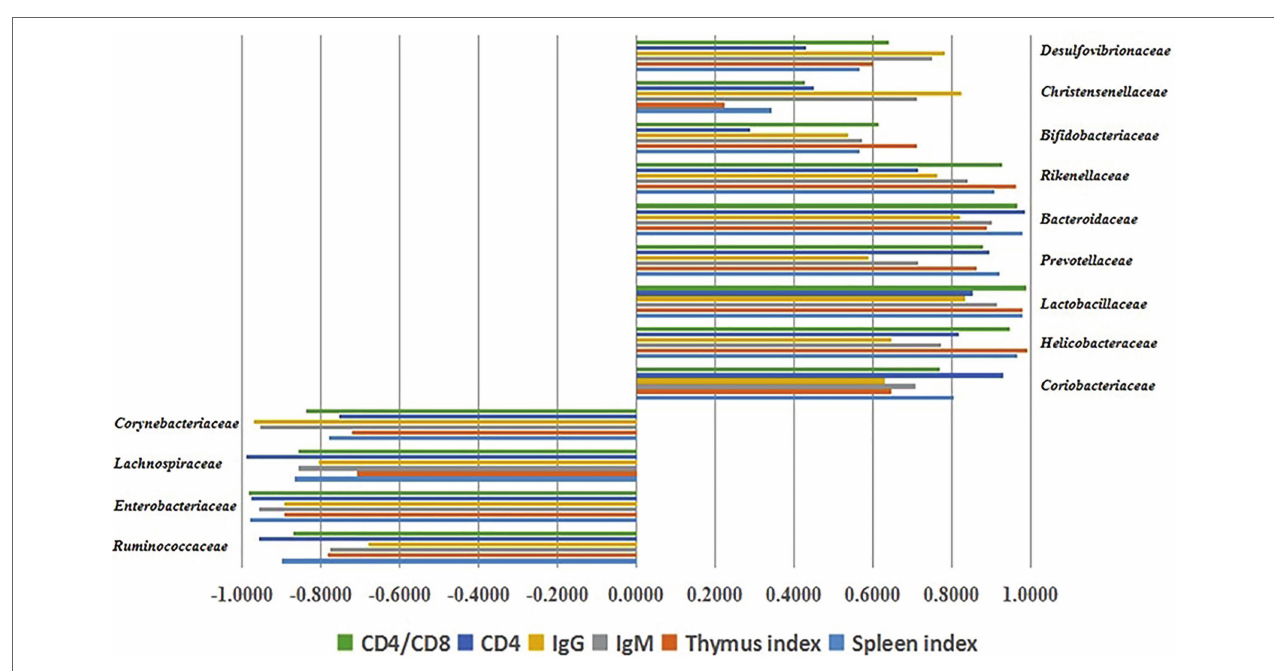
FIGURE 6 | Associations of the gut microbiota constituents at the family level with immune traits, assessed by Pearson’s correlation